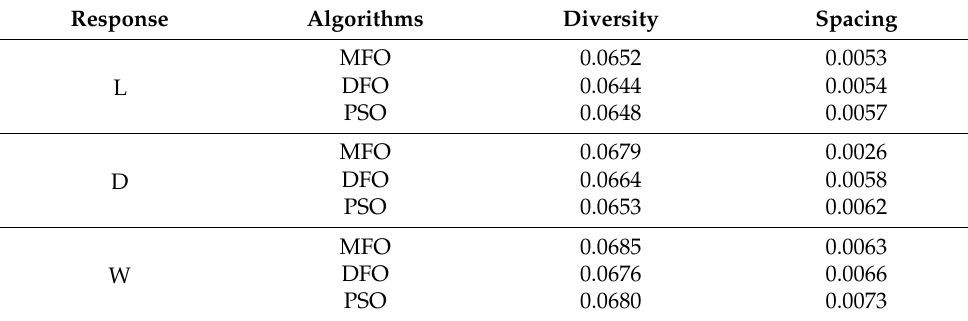
Table 10. Comparison of performance of algorithms using performance